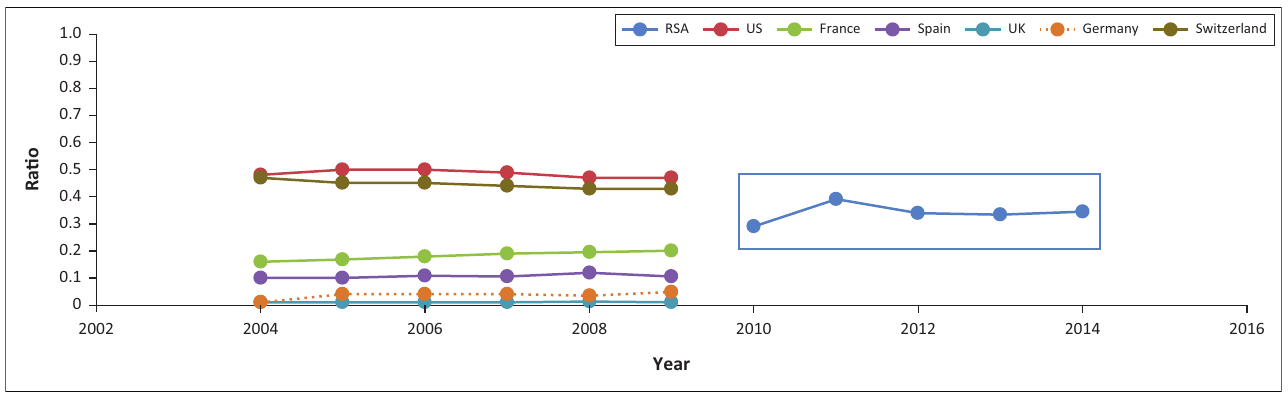
FIGURE 4: Road allocation to income ratio for selected